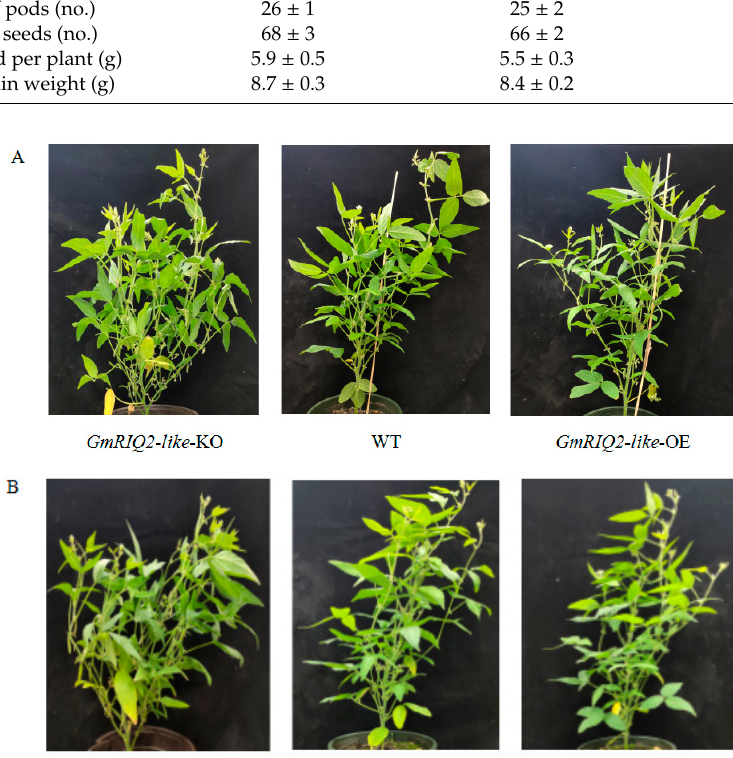
Table 4. A. Agronomic traits of the wild-type (WT) and T 2 generation of GmRIQ2-like- OE and - KO transgenic seedlings.